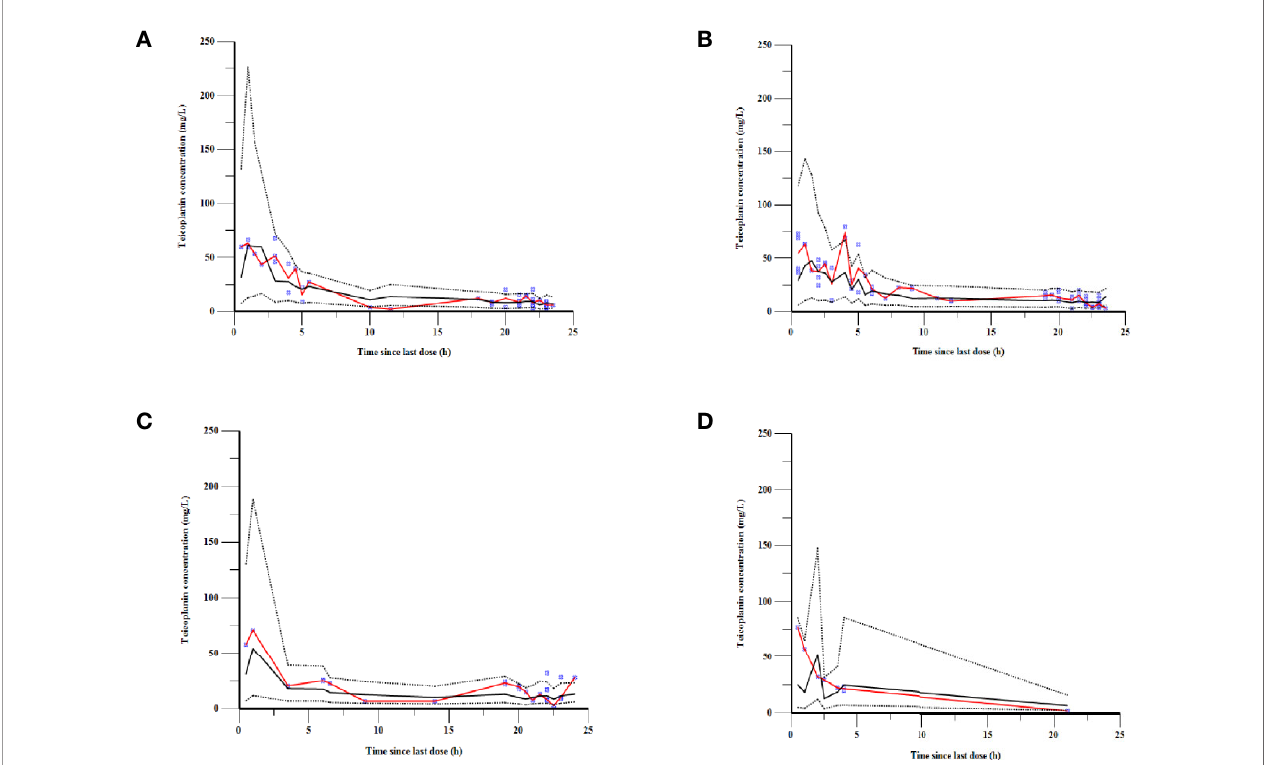
FIGURE 6 | VPCs of the fi nal model for children with (A) augmented renal function, (B) normal renal function, (C) mild renal insuf fi ciency, and (D) moderate renal insuf fi ciency. The blue points represent the observed value. The red lines are the median lines of observed concentrations. The dashed lines show the 2.5th and 97.5th percentiles and the solid line shows the 50 th percentile of the simulated